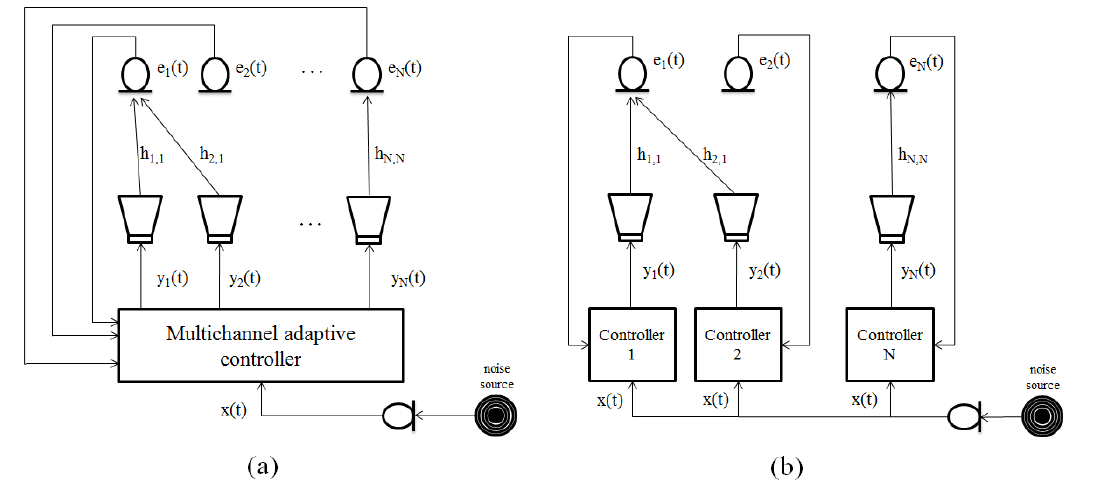
Figure 1. Scheme of ( a ) centralized Active Noise Control (ANC) system with a multichannel controller and ( b ) distributed ANC system with single-channel